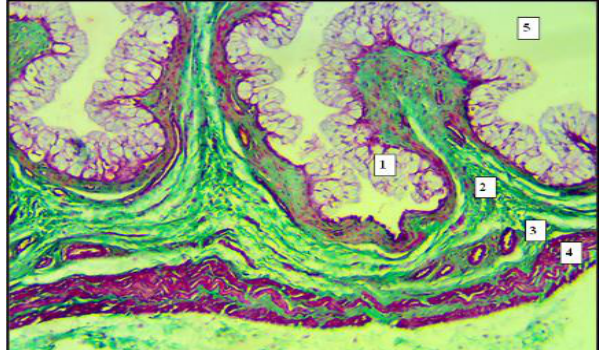
Figure 4. Vagina at fornix showed folded mucosa lined with simple columnar mucous epithelium (1), lamina propria-submucosa (2 and 3) and internal layer of tunica muscularis (4) and vaginal lumen (5). 100X, Masson’s trichrome stain